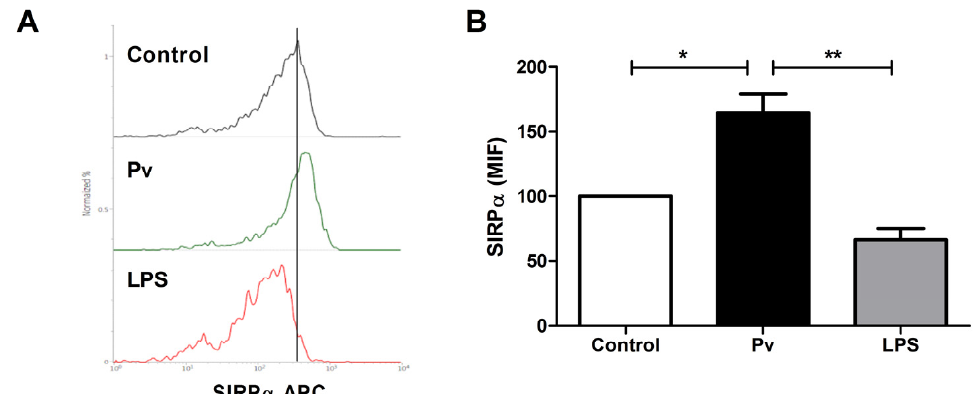
Figure 3. Modulation of SIRP α expression by P. vivax crude extract. PBMCs from healthy individuals were stimulated for 24 h with P. vivax extract (10 µ g/mL) or LPS (5 µ g/mL) and SIRP α expression on cell surface of monocyte-like cells was evaluated by flow cytometry using APC-conjugated anti- SIRP α monoclonal antibody. ( A ) Representative histogram analysis of SIRP α expression in gated monocyte-like cells after stimulation with P. vivax antigens or LPS. ( B ) Levels of SIRP α expression on monocyte-like cells population, as measured by mean fluorescence intensity (MFI). Non-stimulated PBMCs were used as control (Control). Data are shown as mean ± standard error (SEM) and represent one of two independent experiments performed with PBMC samples from five individuals. *: p < 0.05; **: p < 0.01.